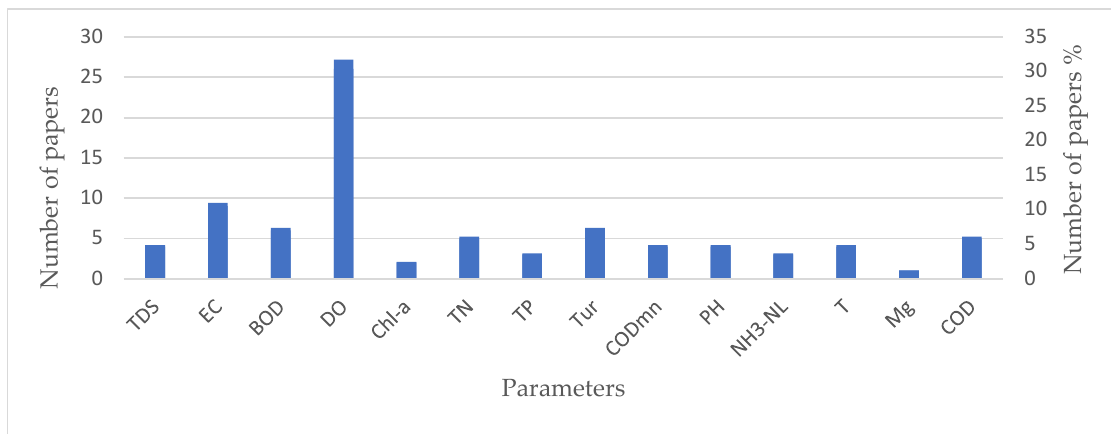
Figure 2. Number of studies employing each parameter of WQ over the years.